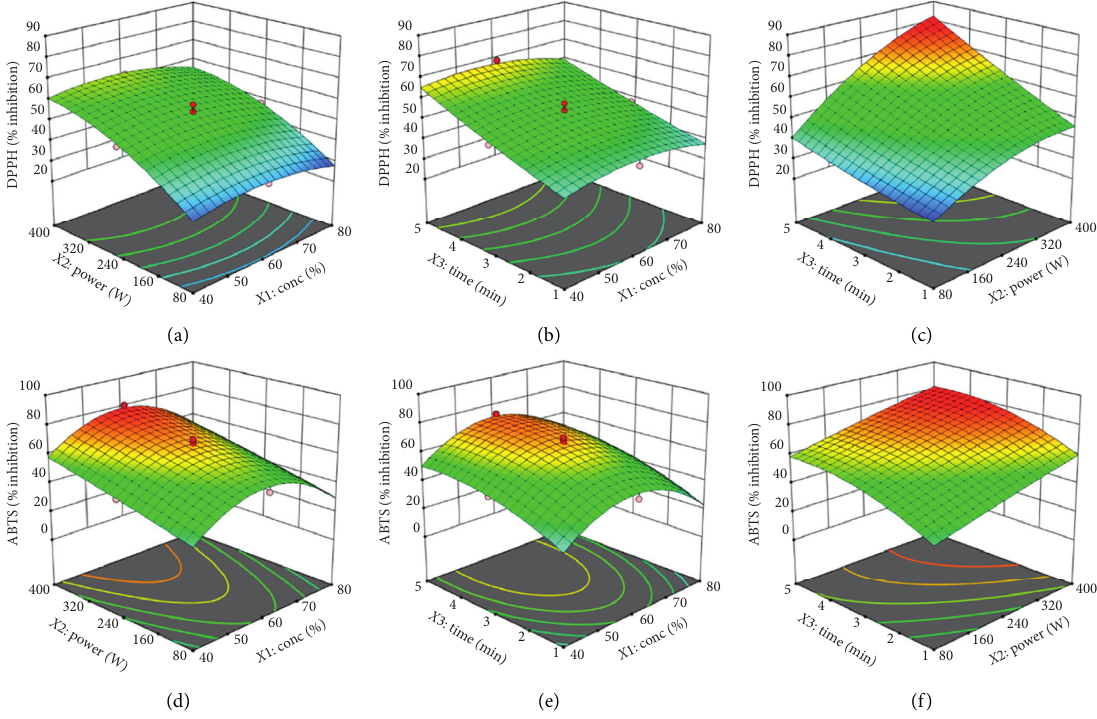
Figure 2: Response surface plot showing the interactive effect of MAE variables on DPPH and ABTS